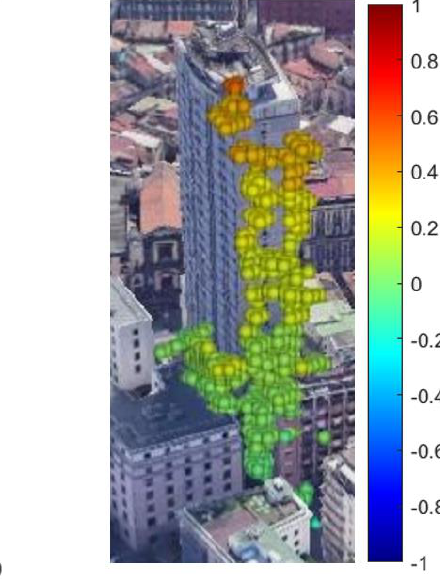
Figure 9. ( a ) MGLRT thermal dilation map with a patch 3 × 3, ( b ) MGLRT height map with a patch 3 × 3 without considering thermal dilation.